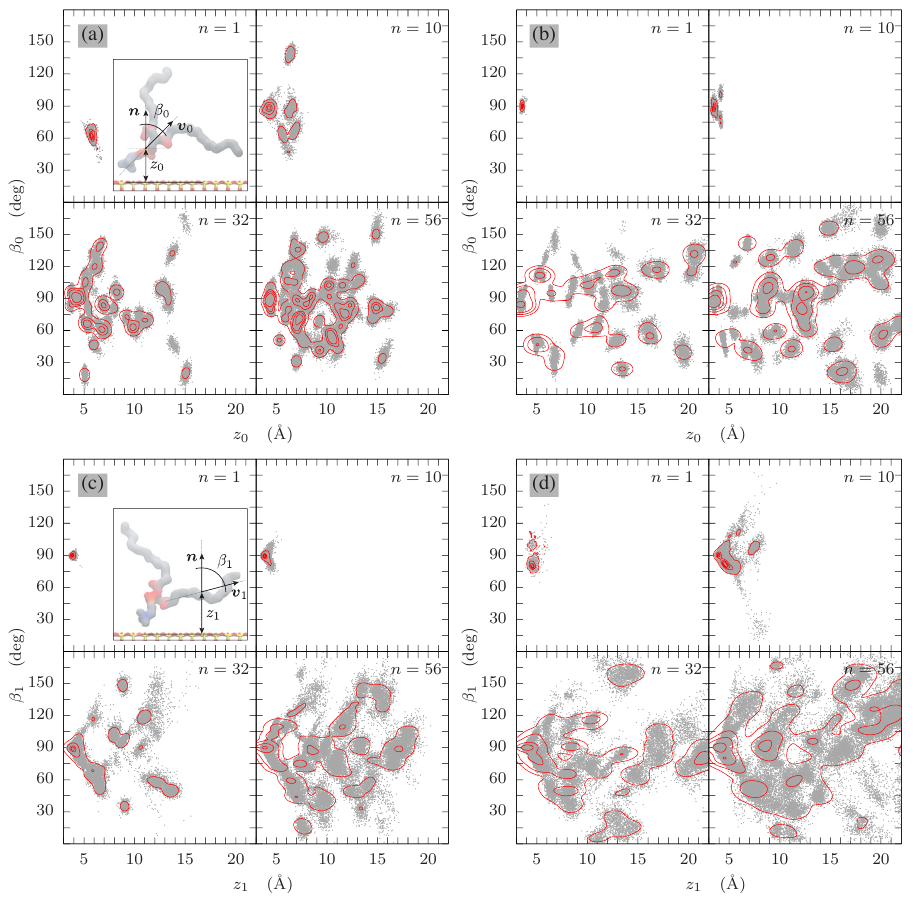
Figure 2. POPC head fragment tilt angles β 0 and β 1 versus their center-of-mass distance with respect to the kaolinite surface z 0 and z 1 at hydrophobic siloxane ( a , c ) and hydrophilic alumina surfaces ( b , d ), respectively. The red contour lines correspond to 10, 25, 50 and 90% confidence intervals of the fitted 2-dimensional kernel densities,